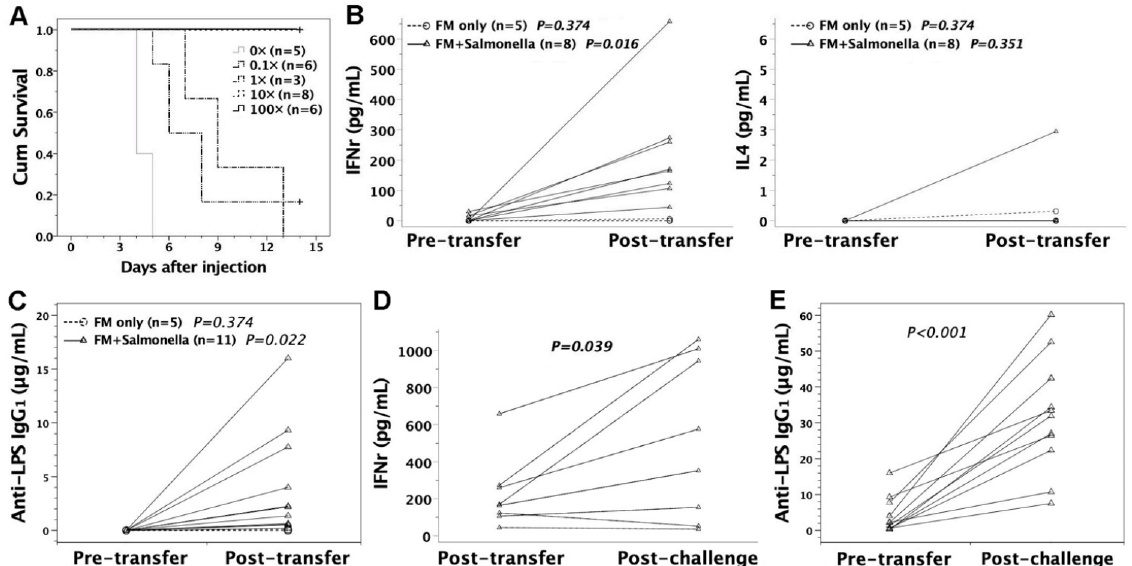
Figure 6. Immunological outcome following adoptive transfer of FMs loaded with heat-killed S. Typhimurium. FVB/N adults were intravenously injected with 2 × 10 7 FMs loaded with heat-killed S. Typhimurium SL1344 (0 × , 0.1 × , 1 × , 10 × , and 100 × in amount) overnight. ( A ) Four weeks later, the recipients were tested for their resistance to lethal challenge of 10 5 live S. Typhimurium. With heat-killed Salmonella of 0.1 × and 1 × , the recipients experienced better survival ( p = 0.004 and 0.012, respectively) than the FM controls without Salmonella loaded (0 × ). When Salmonella doses increased to 10 × and 100 × , all recipients survived lethal challenge, achieving superior survival to Salmonella doses of 0.1 × ( p = 0.001 and 0.005, respectively) and 1 × ( p < 0.001 and p = 0.002, respectively). ( B ) Following adoptive transfer, serum IFN γ was upregulated in recipients receiving Salmonella -loaded FMs (FM + Salmonella , 10 × or 100 × ), compared to the controls receiving FMs without Salmonella loaded (FM only, 0 × ). However, IL4 remained hardly detectable in the FM + Salmonella and FM-only groups. ( C ) Serum anti-LPS IgG 1 levels were examined in FVB/N recipients following cell transfer by ELISA using mouse monoclonal anti-LPS IgG 1 (1E6, Abcam) as the standard curve. FM + Salmonella significantly generated anti-LPS IgG 1 in sera, as opposed to FM only. ( D , E ) In the recipients (FM + Salmonella ) surviving Salmonella challenge, serum IFN γ and anti-LPS IgG 1 were further boosted. Coupled triangles or circles represent pairwise data of pre- vs. post-transfer or post-transfer vs. post-challenge from an individual